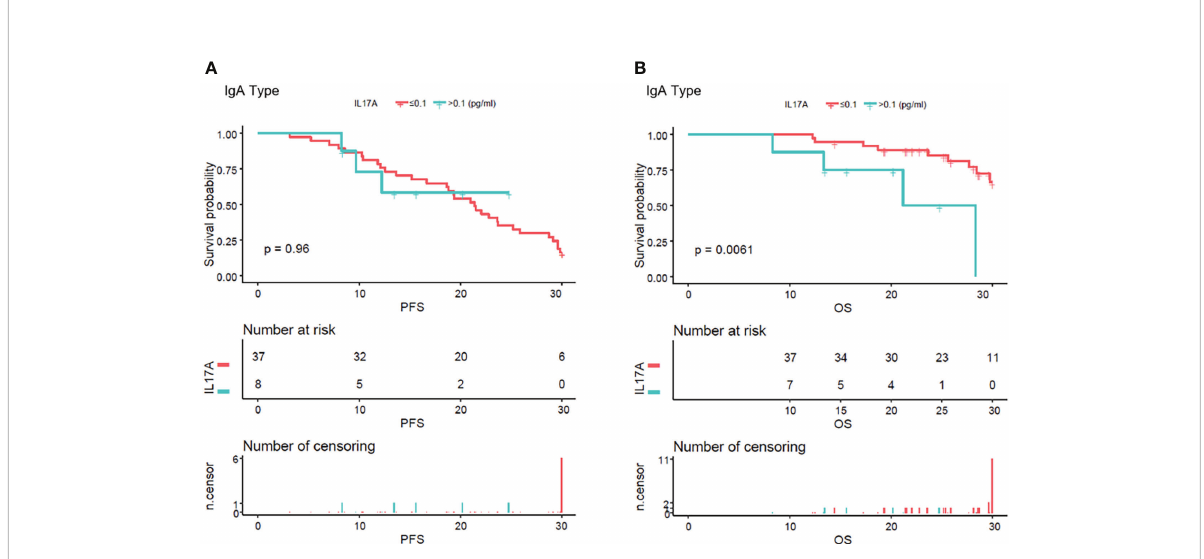
FIGURE 6 Kaplan – Meier curves of progression-free survival (PFS) and overall survival (OS) according to mean serum IL-17A levels in IgA type multiple myeloma patients. (A) There were no obvious difference in between the patients with serum IL-17A ≤ 0.1 pg/ml and IL-17A > 0.1 pg/ml (p = 0.96). (B) Compared with patients with serum IL-17A > 0.1 pg/ml, OS was signi fi cantly lower in patients with serum IL-17A ≤ 0.1 pg/ml (p =